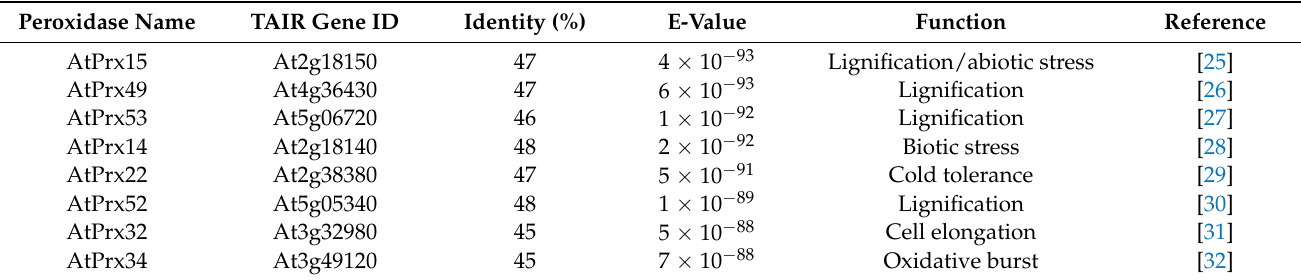
Table 3. Reported function of Arabidopsis peroxidases which show highest homology to mature PpaPrx19 protein sequence after a BLAST search with